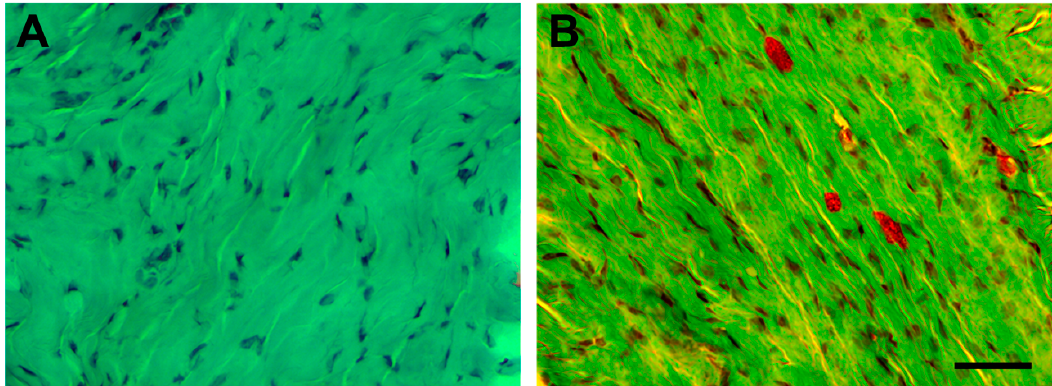
Figure 4. Stained longitudinal images with Safranin O of a normal Achilles tendon ( A ) and of an injured Achilles tendon of rats euthanized after one week after injection of collagenase showing the presence of fibrocartilaginous tissue ( B ). The scale bar is at 50 μ m.